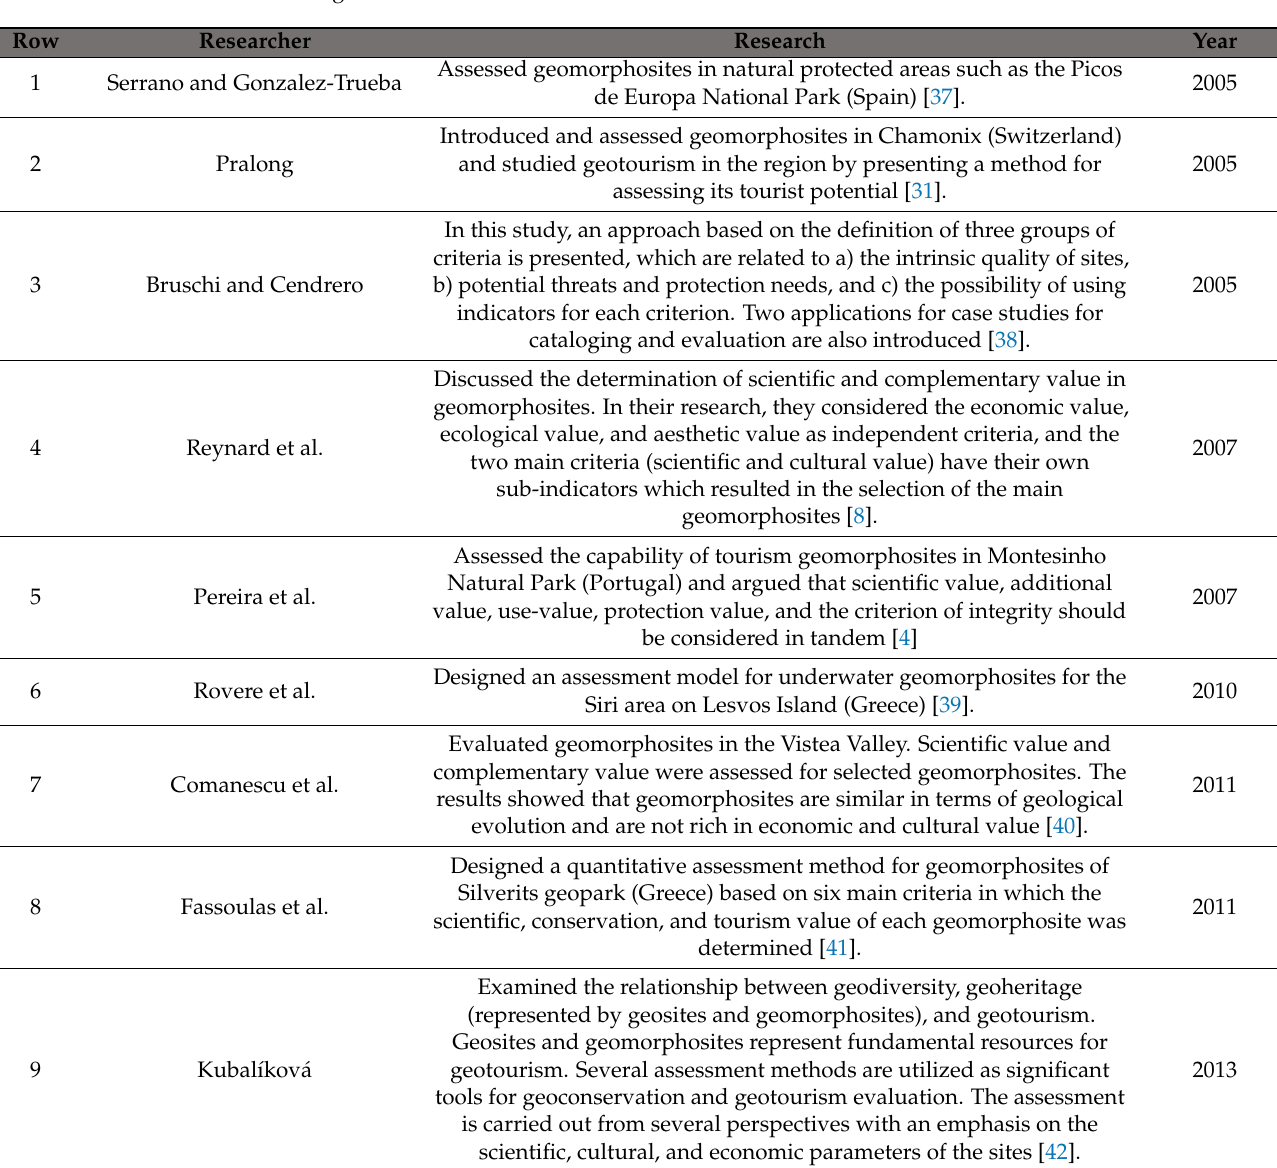
Table 1. Relevant research on geosites and geomorphosites as a basis for the study and practice of